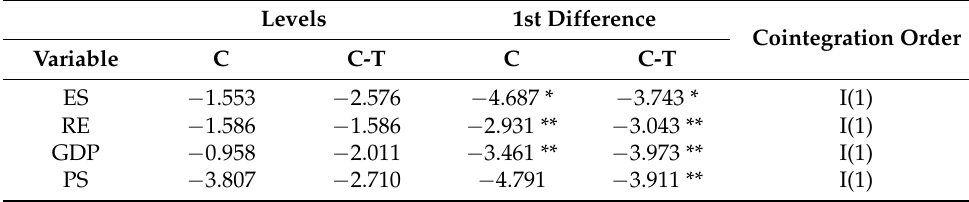
Table 4. Pesaran CIPS unit root test with cross-sectional dependence test results.